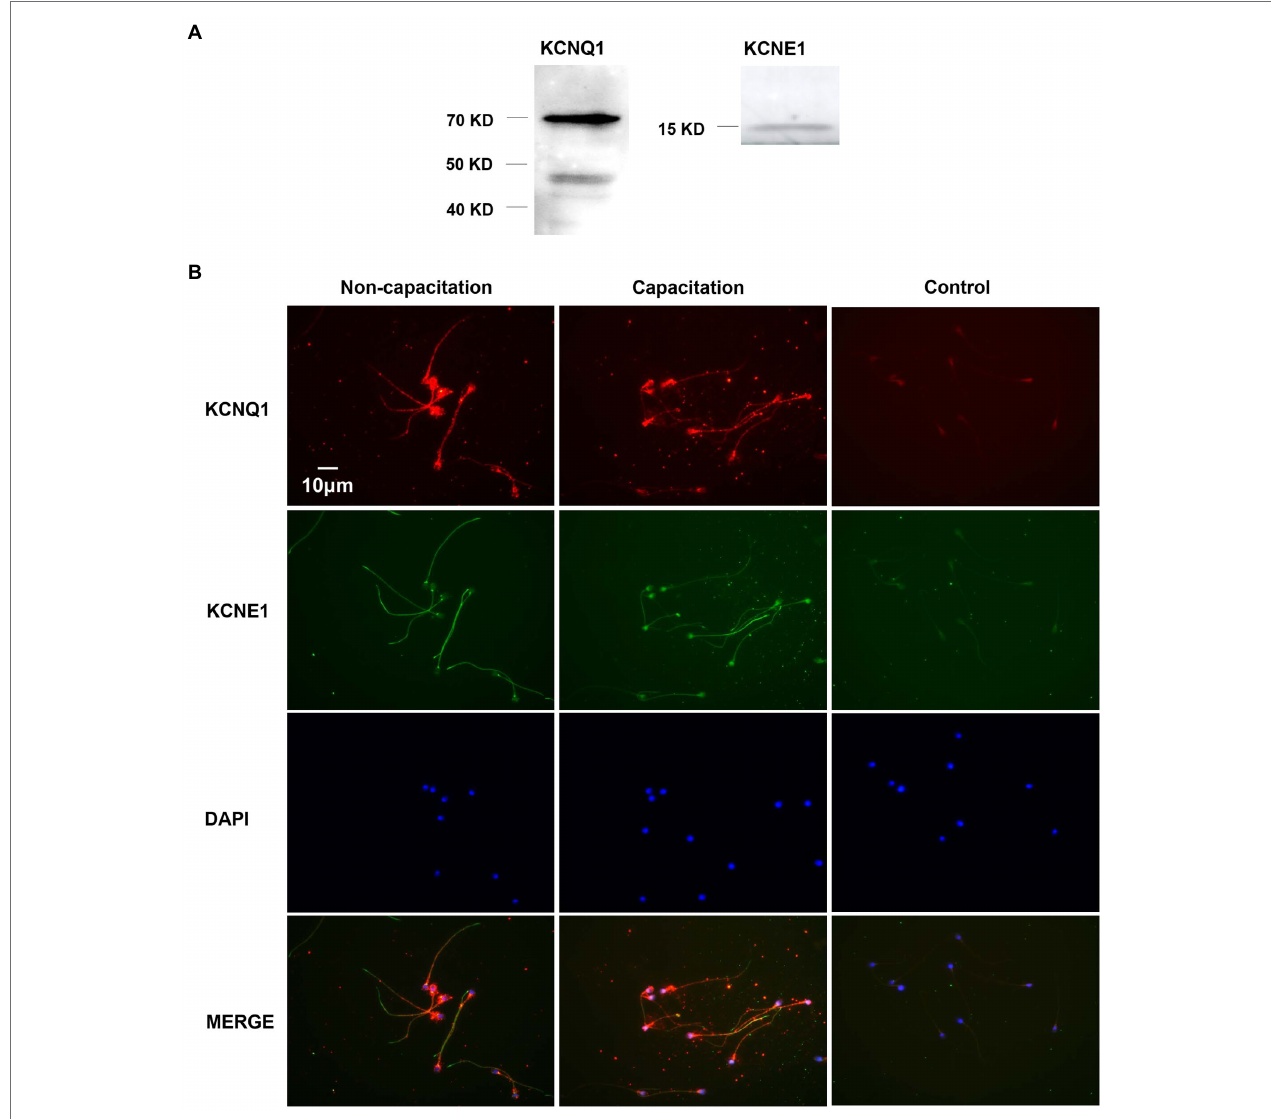
FIGURE 1 | Expression and localization of KCNQ1 and KCNE1 in human sperm. (A) Human sperm were lysed after capacitation for 3 h. Sperm proteins were separated and analyzed using 10% SDS-PAGE and Western blotting, using antibodies for KCNQ1 (Abcam) and KCNE1 (Abcam). The figure is representative of 3 separate experiments. The full uncropped immunoblots was provided in the supplementary data ( Supplementary Figure 1 ). (B) Indirect immunofluorescence of KCNQ1 (Santa Cruz) and KCNE1 (Invitrogen) in human sperm before and after capacitation. KCNQ1 (red), KCNE1 (green), and co-localization of KCNQ1 and KCNE1 (merge). The negative control cells were incubated with normal IgG as the primary antibodies. The nuclei of spermatozoa were stained blue with DAPI. The figure is representative of 3 separate